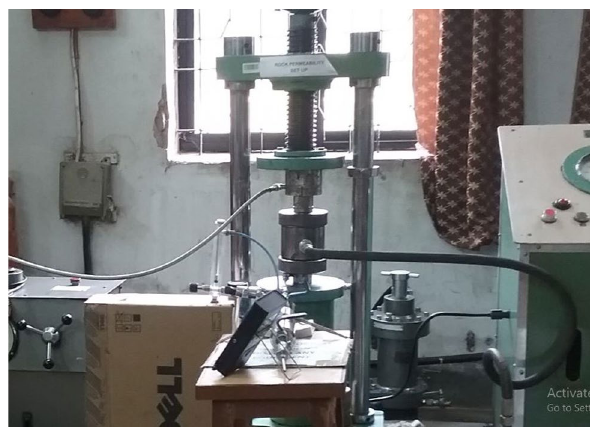
Fig. 4 Experimental set-up for coal gas